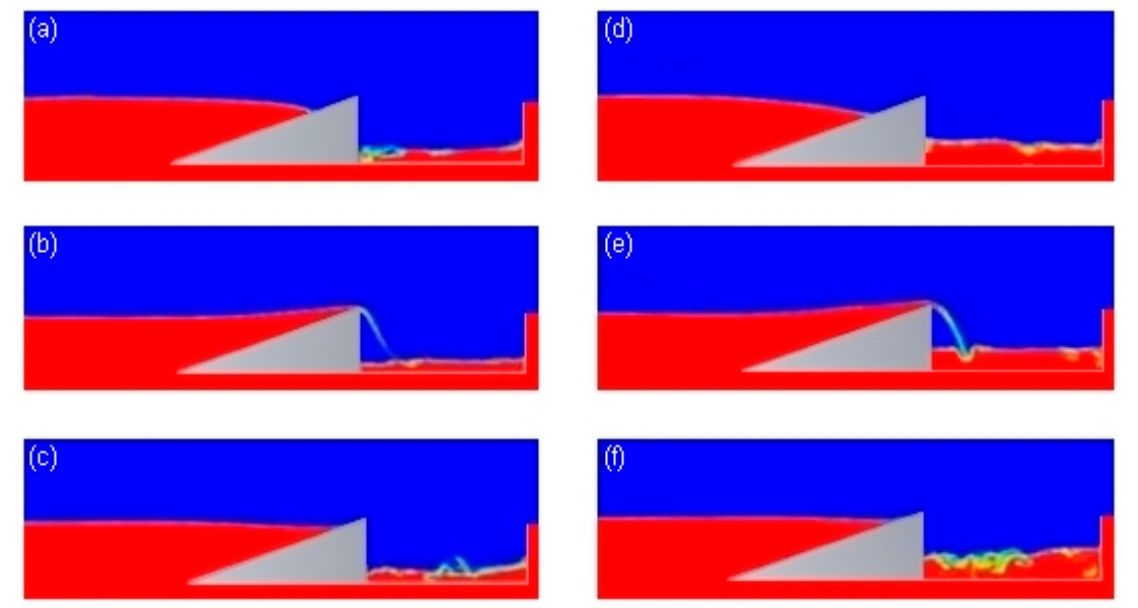
Figure 19. Fluid-dynamic behavior during the maximum mass flow peaks referring to the RG coastal region, considering the representative regular waves for ( a ) 𝑡 = 178 s; ( b ) 𝑡 = 182 s; and ( c ) 𝑡 = 186 s; and the realistic irregular waves for ( d ) 𝑡 = 721 s; ( e ) 𝑡 = 725 s; and ( f ) 𝑡 = 729 s. Still referring to the accumulation of water in the reservoir, Figure 20 presents the phase